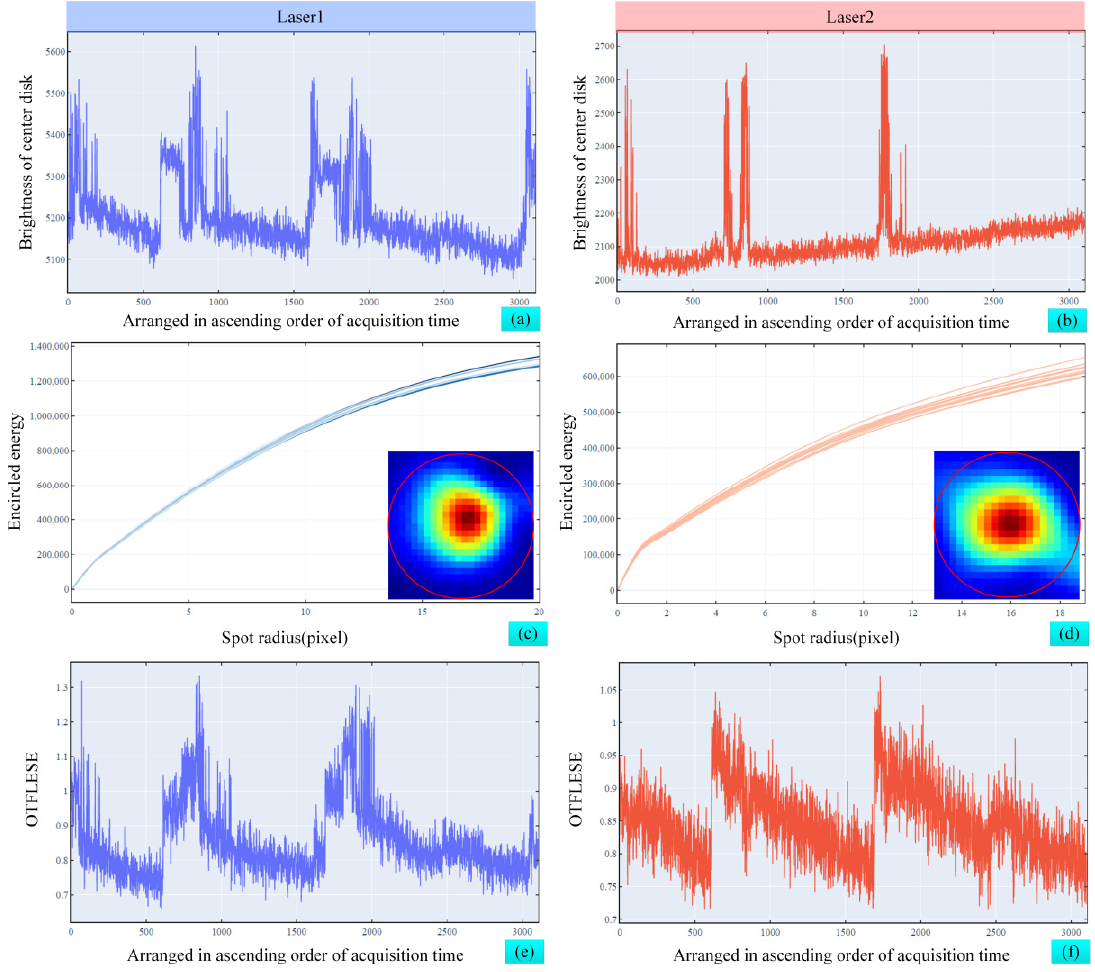
Figure 8. Analysis of changes in the laser energy at the emission time. ( a ) and ( b ) represent respectively center disk brightness of beam 1&2. ( c ) and ( d ) represent respectively Encircled energy diagram of beam 1&2. ( e ) and ( f ) represent respectively OTF-LESE of beam 1&2.